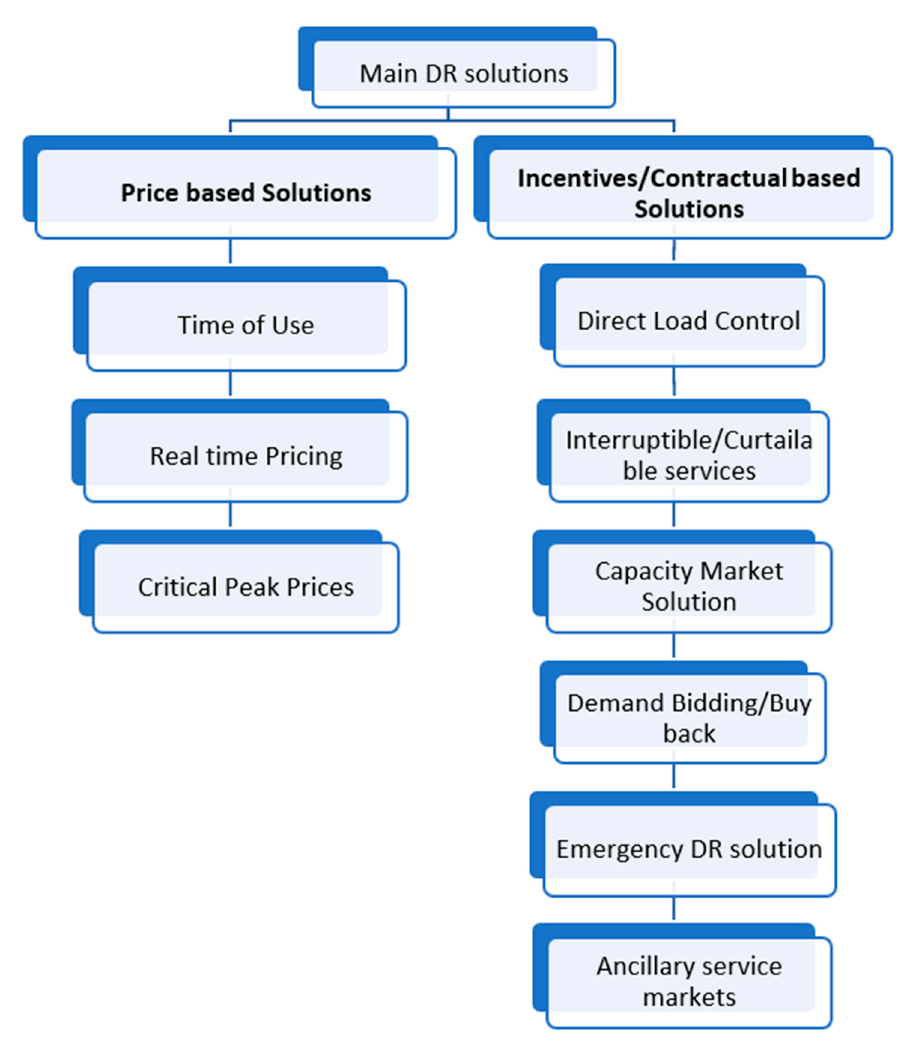
Figure 1. DR solutions (Source: adapted from [11]).